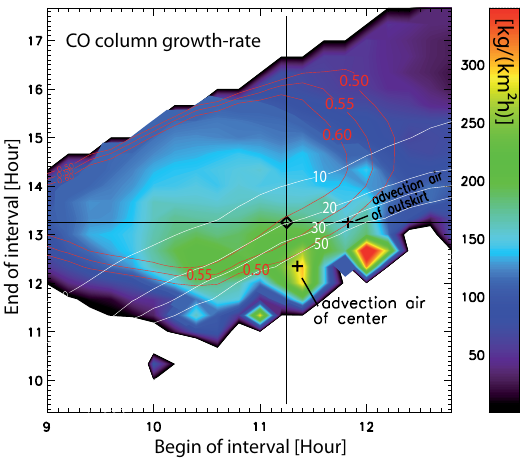
Fig. 4. Sensitivity of the calculated emission flux to the chosen time interval. False-color shows the resulting emission fluxes at UNAM around noon. Red contour lines mark in the parameter-space the value of R (Pearson correlation coefficient of the resulting dataset). White contour lines show the error of the obtained emission flux in kgkm − 2 h − 1 (taken from the 95% confidence interval). The finally chosen time interval is marked as a diamond with a black horizontal line at 13:15 and vertical line at 11:15. Two crosses mark a local maximum and minimum, referred in the